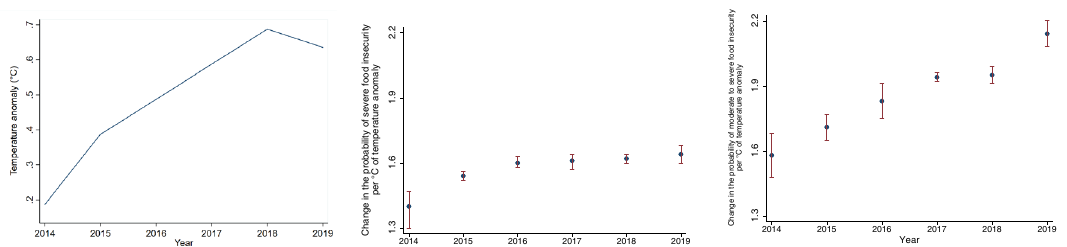
Figure 4. Annual temperature anomaly and time-varying regression